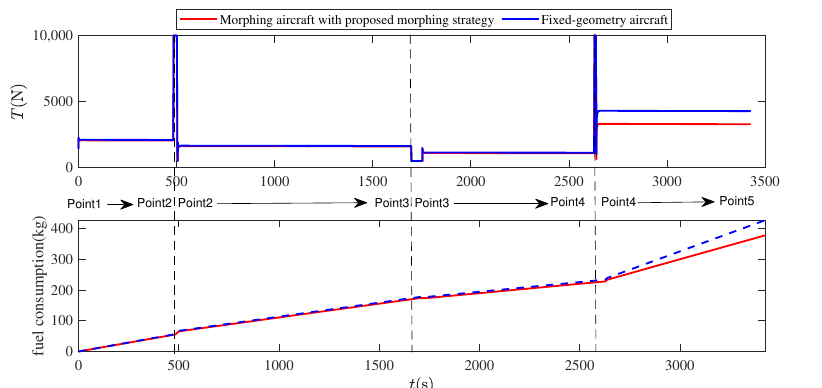
Figure 14. Engine thrust and fuel consumption of the comparative simulation in Section 5.1.